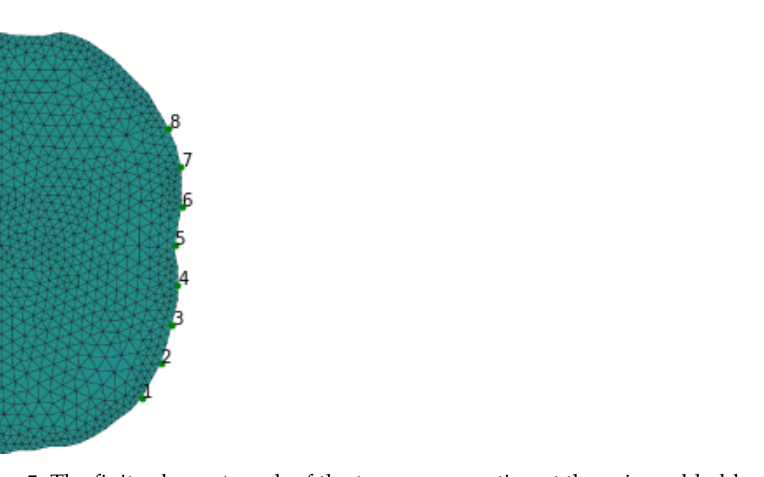
Figure 5. The finite element mesh of the torso cross section at the urinary bladder